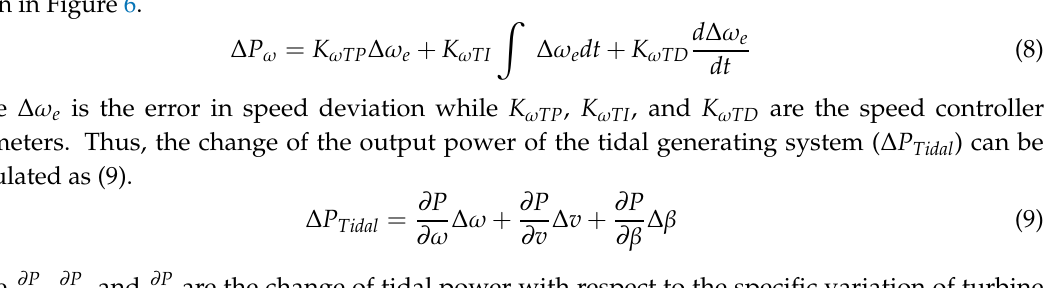
Figure 4. Deloading philosophy of tidal turbine [24].